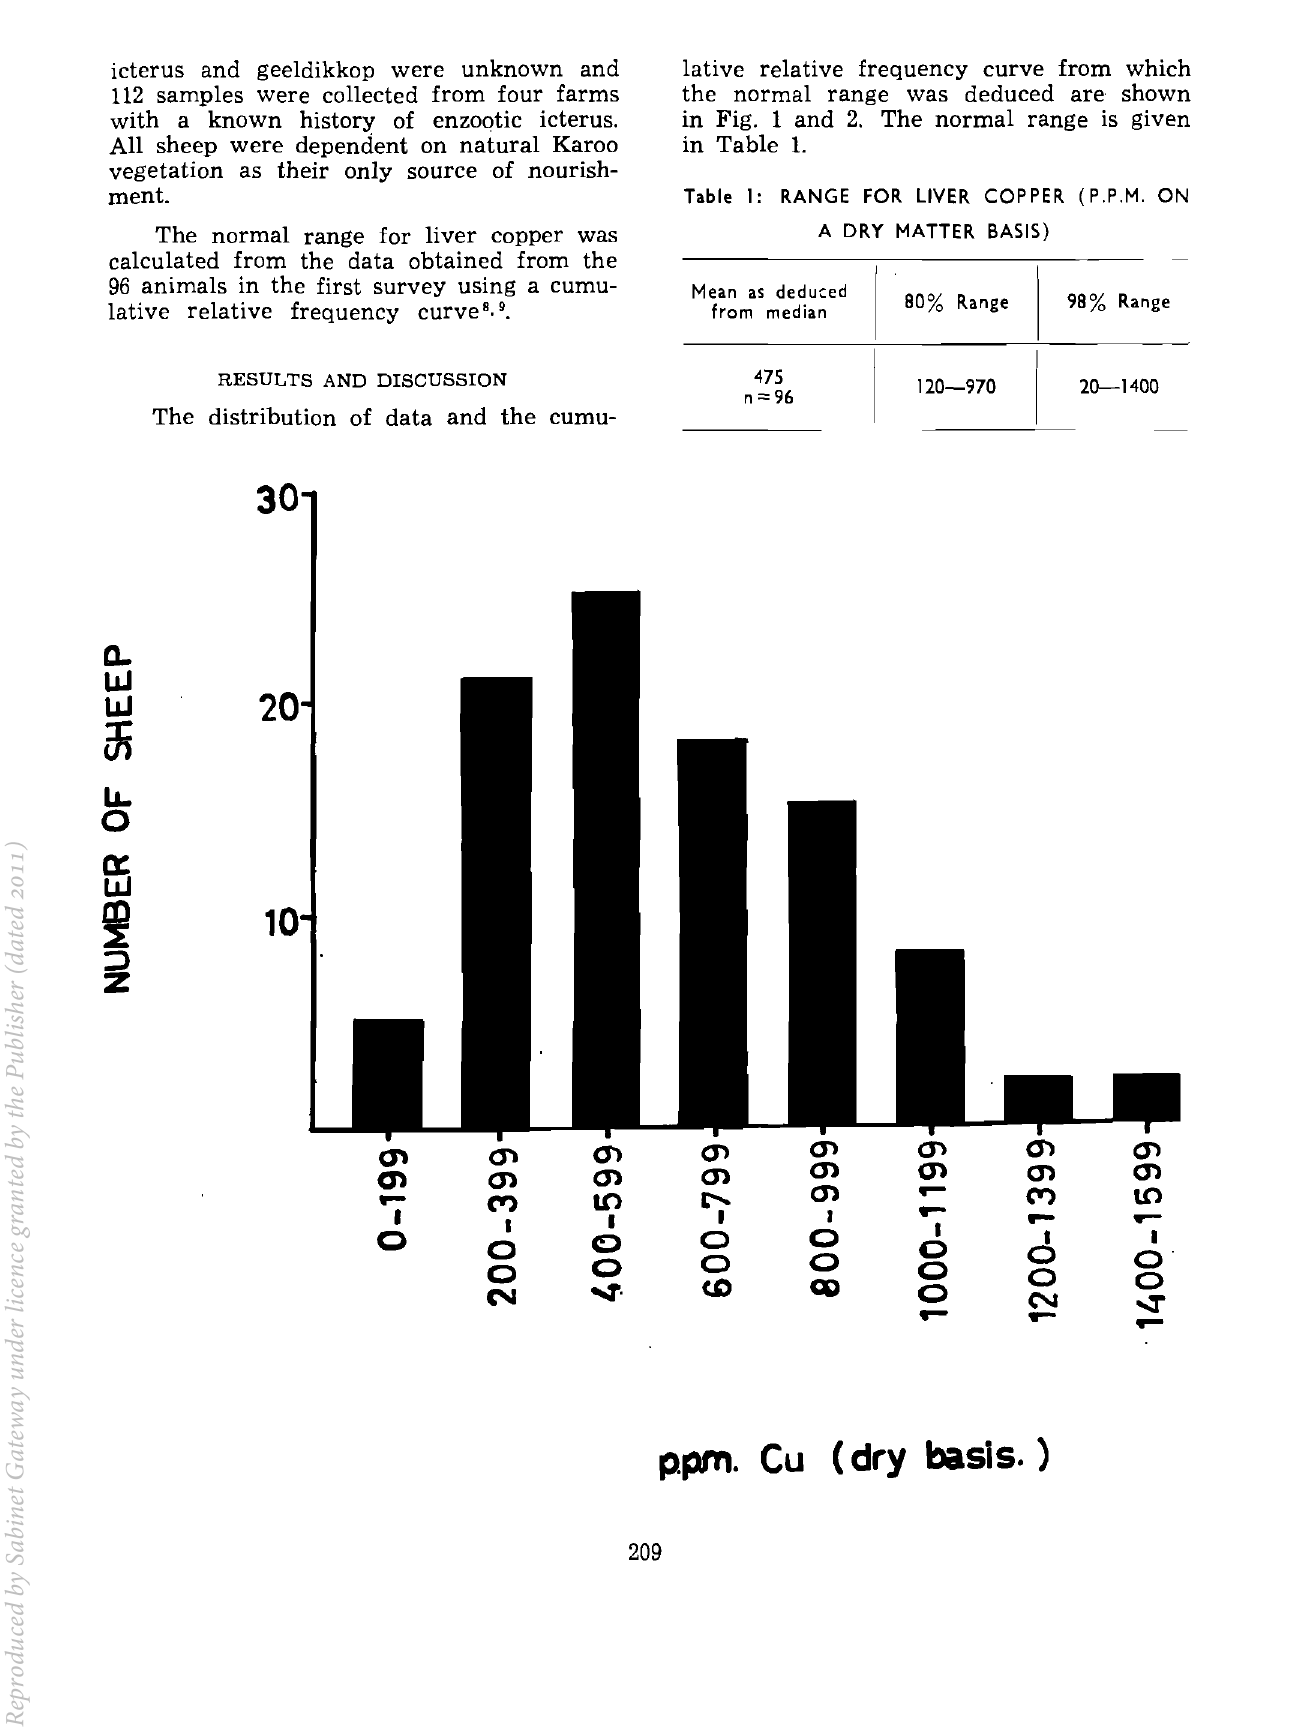
Table 1: RANGE FOR LIVER COPPER (P.P.M. ON A DRY MATTER